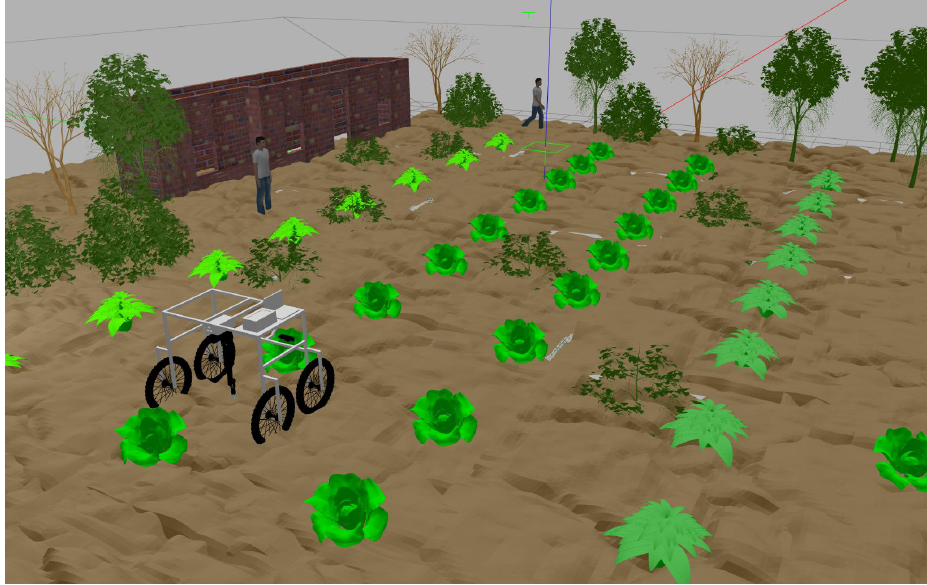
Figure 5. Simulated environment of strip-cropping field developed in Gazebo for algorithm tests. Source: